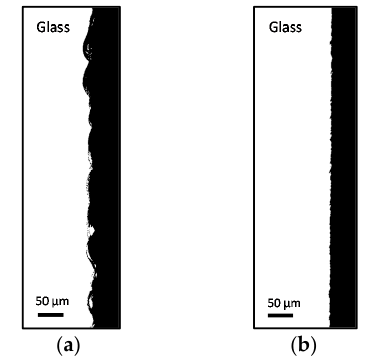
Figure 3. Top-view microscope images of example surfaces after SACE milling: a cut made with the lab set-up ( a ) and a cut made on the industrial Microfor SACE machine (Posalux SA) ( b ). Scale bars are in 50 µm.